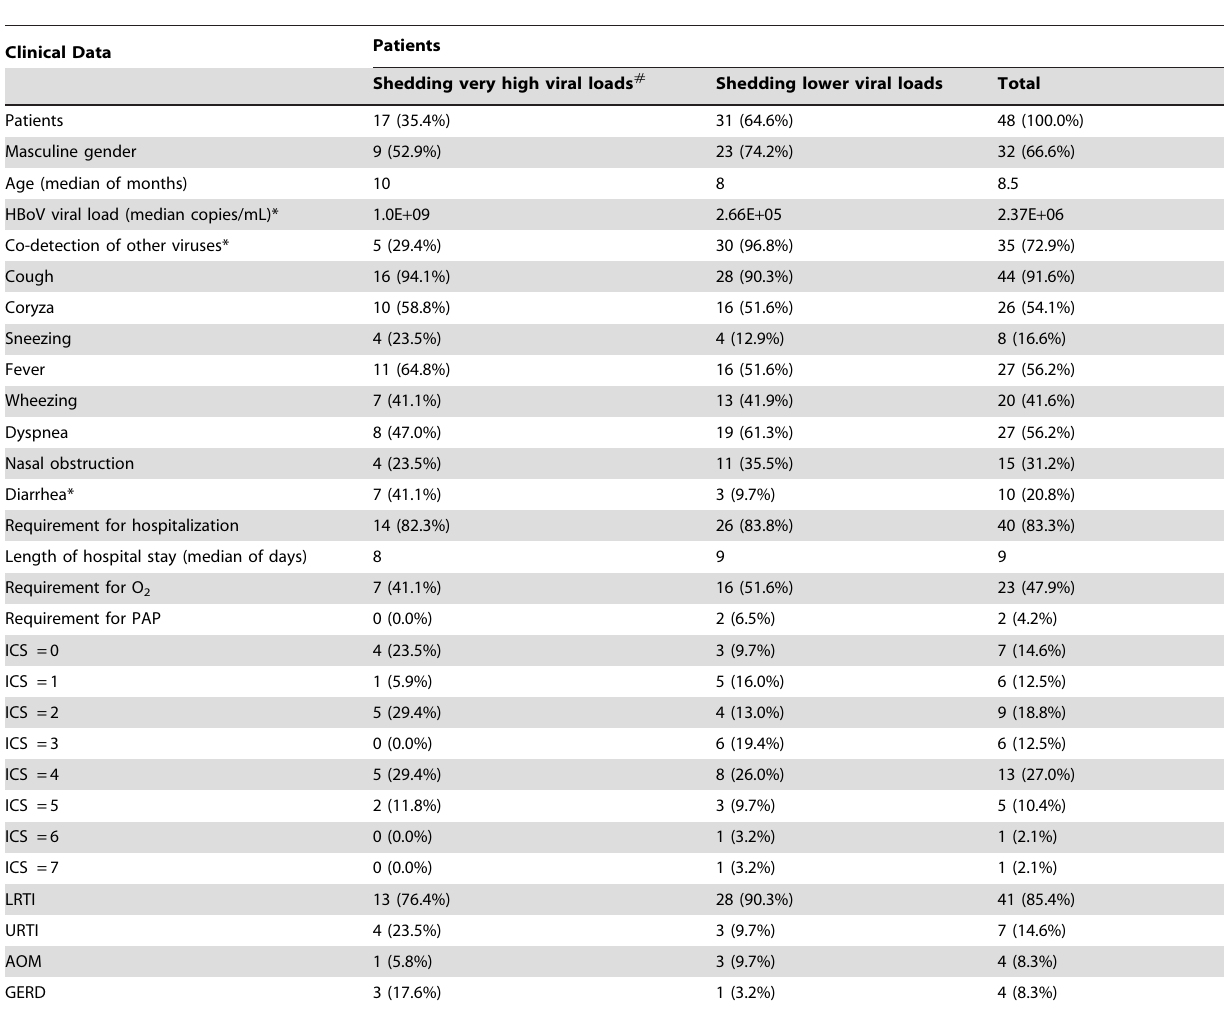
Table 2 . Clinical and demographic data of ARI patients shedding very high or lower HBoV loads.